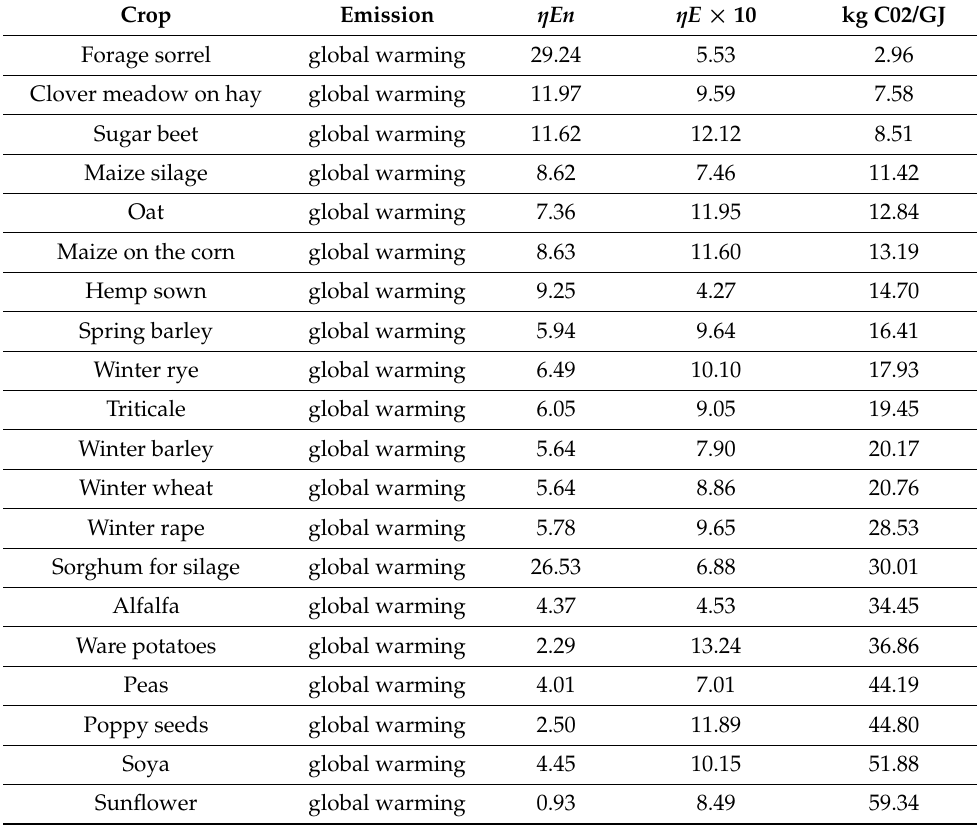
Table A8. Average emissions global warming and efficiency of crops.